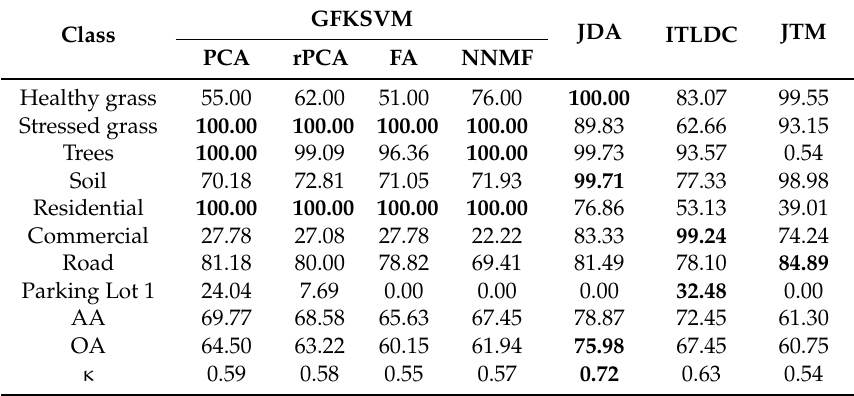
Table 4. Classification accuracies (%) and kappa statistic (k) for considered DA algorithms applied to Houston data (Right Ñ Left).